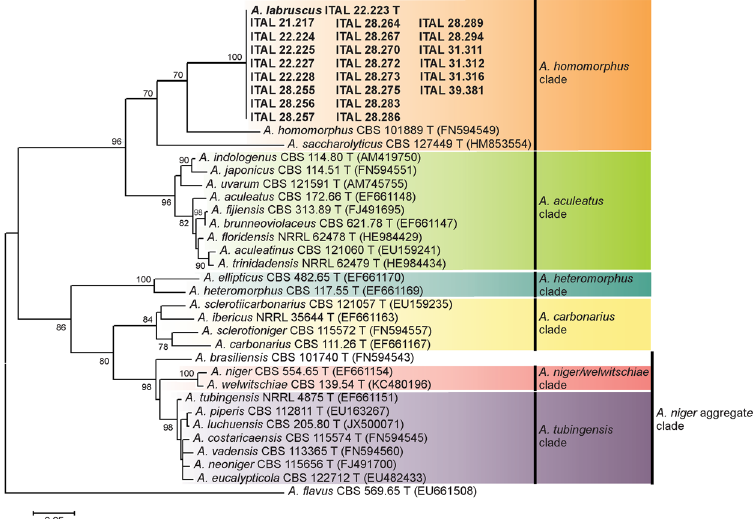
Figure 1. Maximum Likelihood phylogenetic tree based on partial calmodulin gene ( CaM ) sequence data for Aspergillus section Nigri . Bootstrap percentages (based on 1,000 resampled datasets) are shown at nodes. Aspergillus flavus was used as